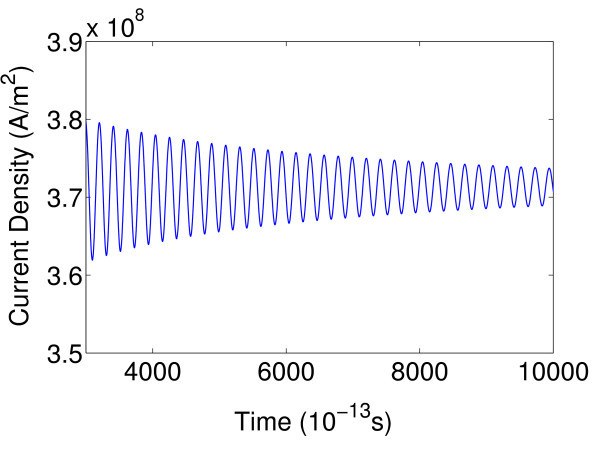
Periodic oscillation damping with NA = 2.4 × 1016cm-3.